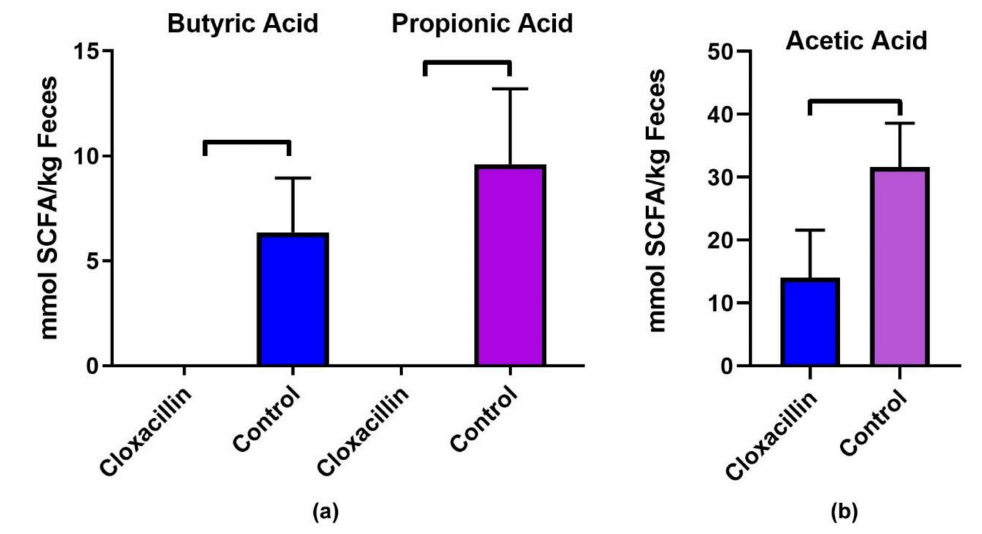
Figure 5. Short-chain fatty acids are decreased in antibiotic treated mice. Significant decreases in SCFCs were found in C. parvum infected and cloxacillin treated mice compared to C. parvum infected vehicle treated controls. These include ( a ) butyric ( p = 0.005) and propionic ( p = 0.004) acids levels below the detection limits and ( b ) levels of acetic (60% reduction compared to control, p =